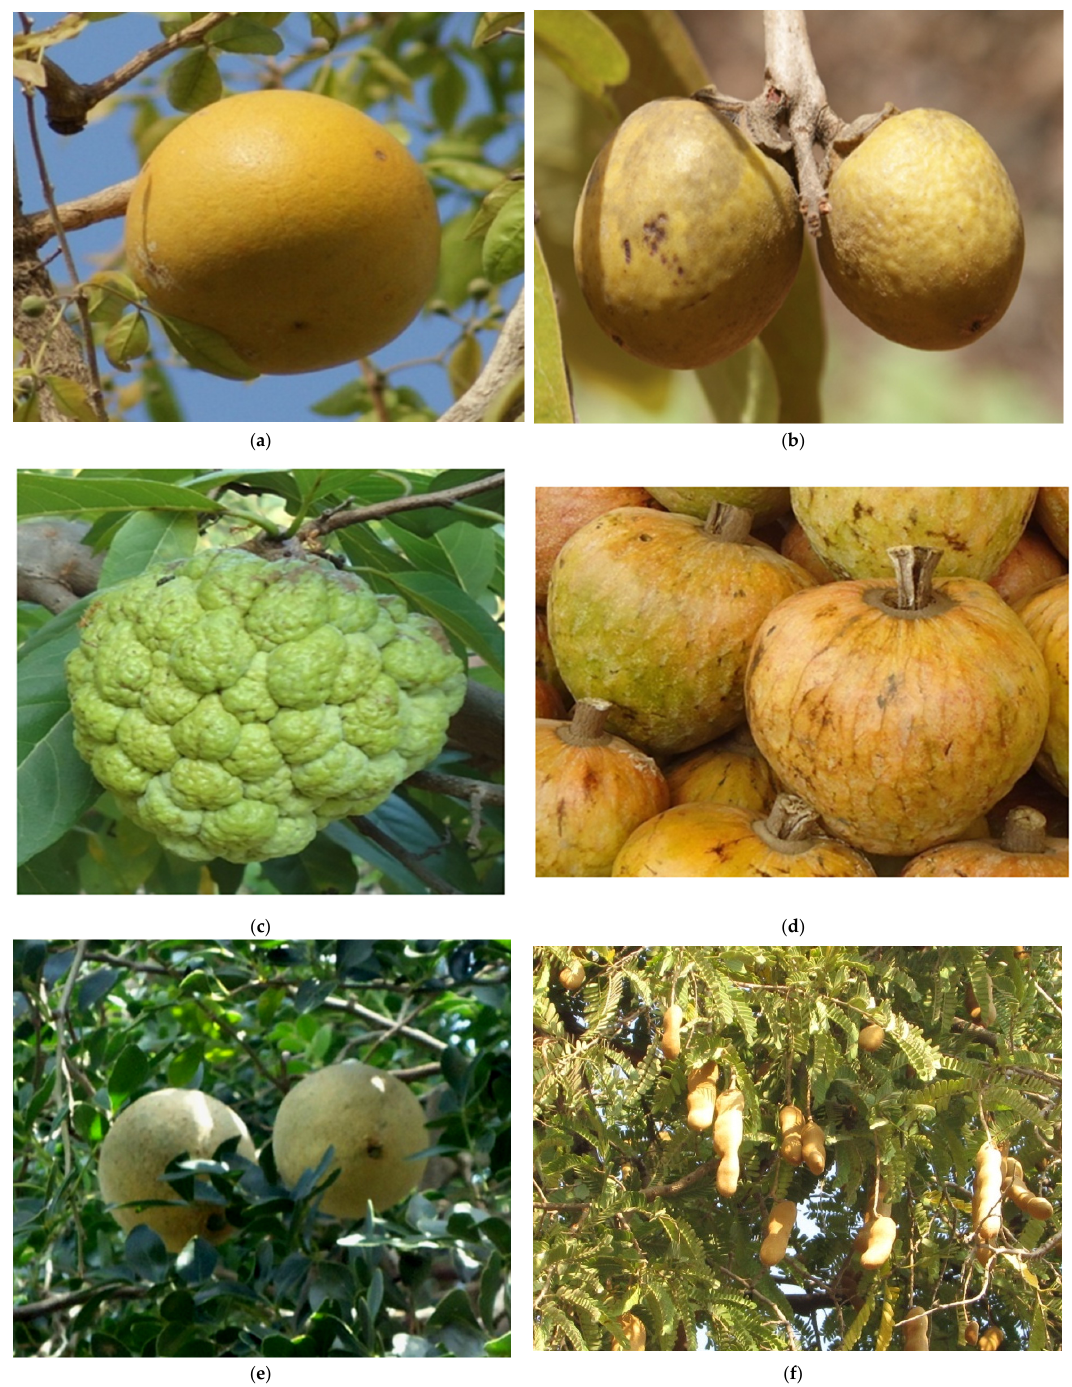
Figure 1. Edible Fruits in Natural Forests: ( a ). Aegle marmelos (L.) Corr; ( b ) Diospyros melanoxylon Roxb; ( c ) Annona squamosa Linn; ( d ). Annona reticulata Linn; ( e ) Feronia limonia (L.) Swingle; ( f ) Tamarindus indica Linn.